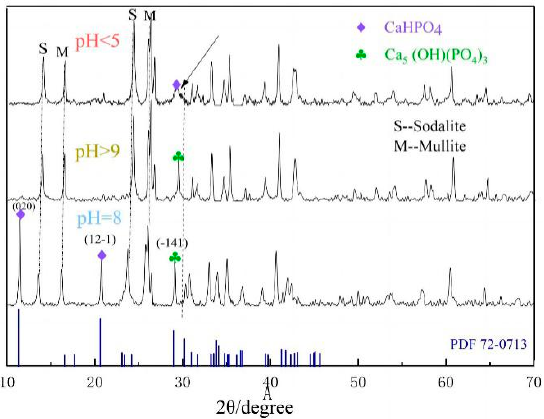
Figure 9. XRD patterns of adsorbed sediments at different pH values.